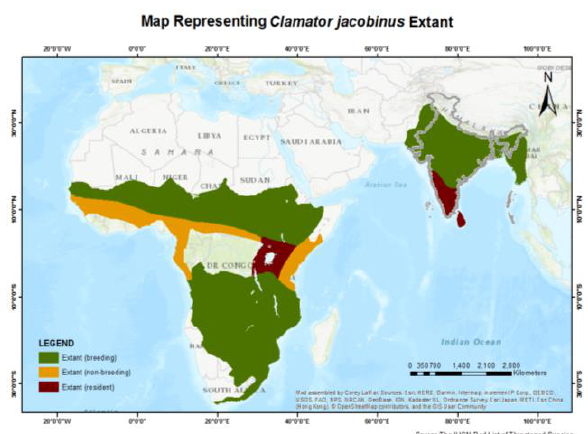
Figure 2. Map showing extant of Clamator